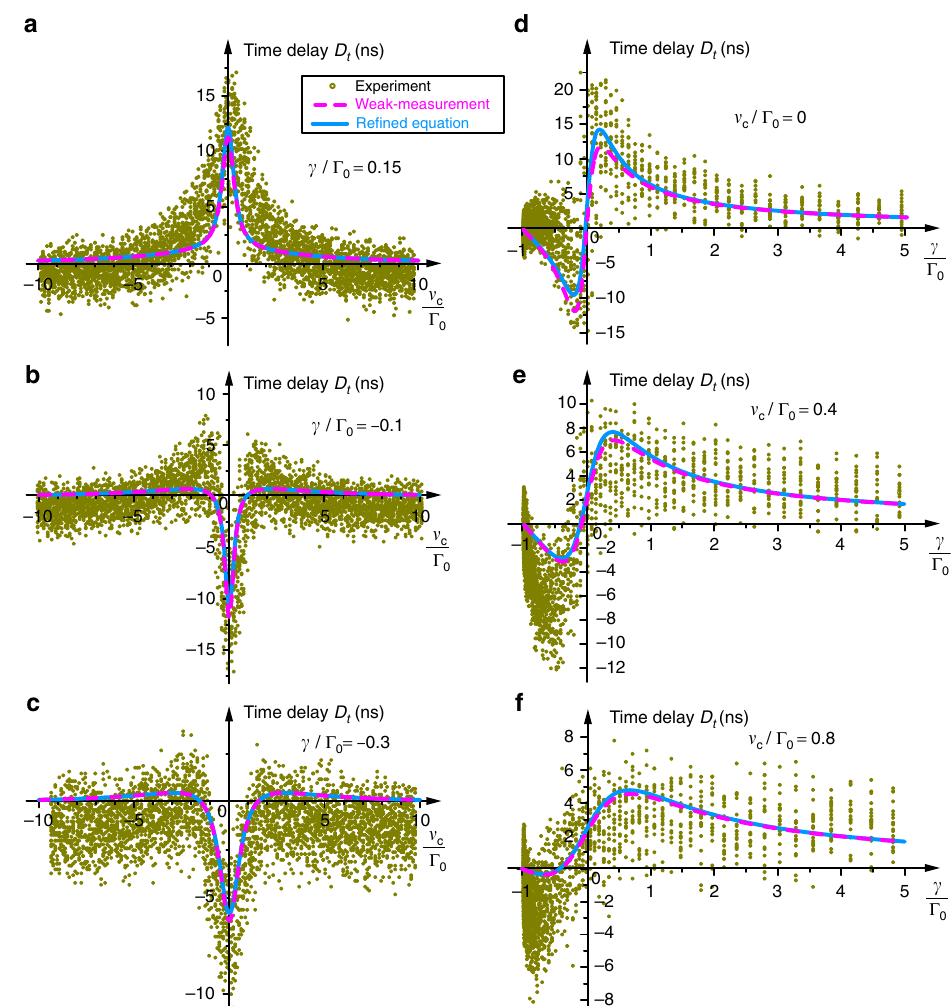
Figure 5 | Experimentally measured anomalous time shifts of light pulses transmitted through a waveguide-coupled resonator. Time delays D t of the transmitted pulses as functions of ( a – c ) the frequency detuning n c at different coupling parameters g and ( d – f ) the coupling detuning g at different frequency detunings n c . Each symbol corresponds to a single time-delay measurement. The magenta dashed curves represent the theoretical weak measurement equations (11) and (12). The cyan solid curves represent the theoretical results obtained using the refined equations, which include the second derivative of the transmission coefficient (see Supplementary Note 2). Despite the large dispersion of the experimental data, the resonant behaviour in the vicinity of the critical coupling ( n c , g ) ¼ (0, 0) is clearly seen and the behaviour of the time delays is in good agreement with the theoretical